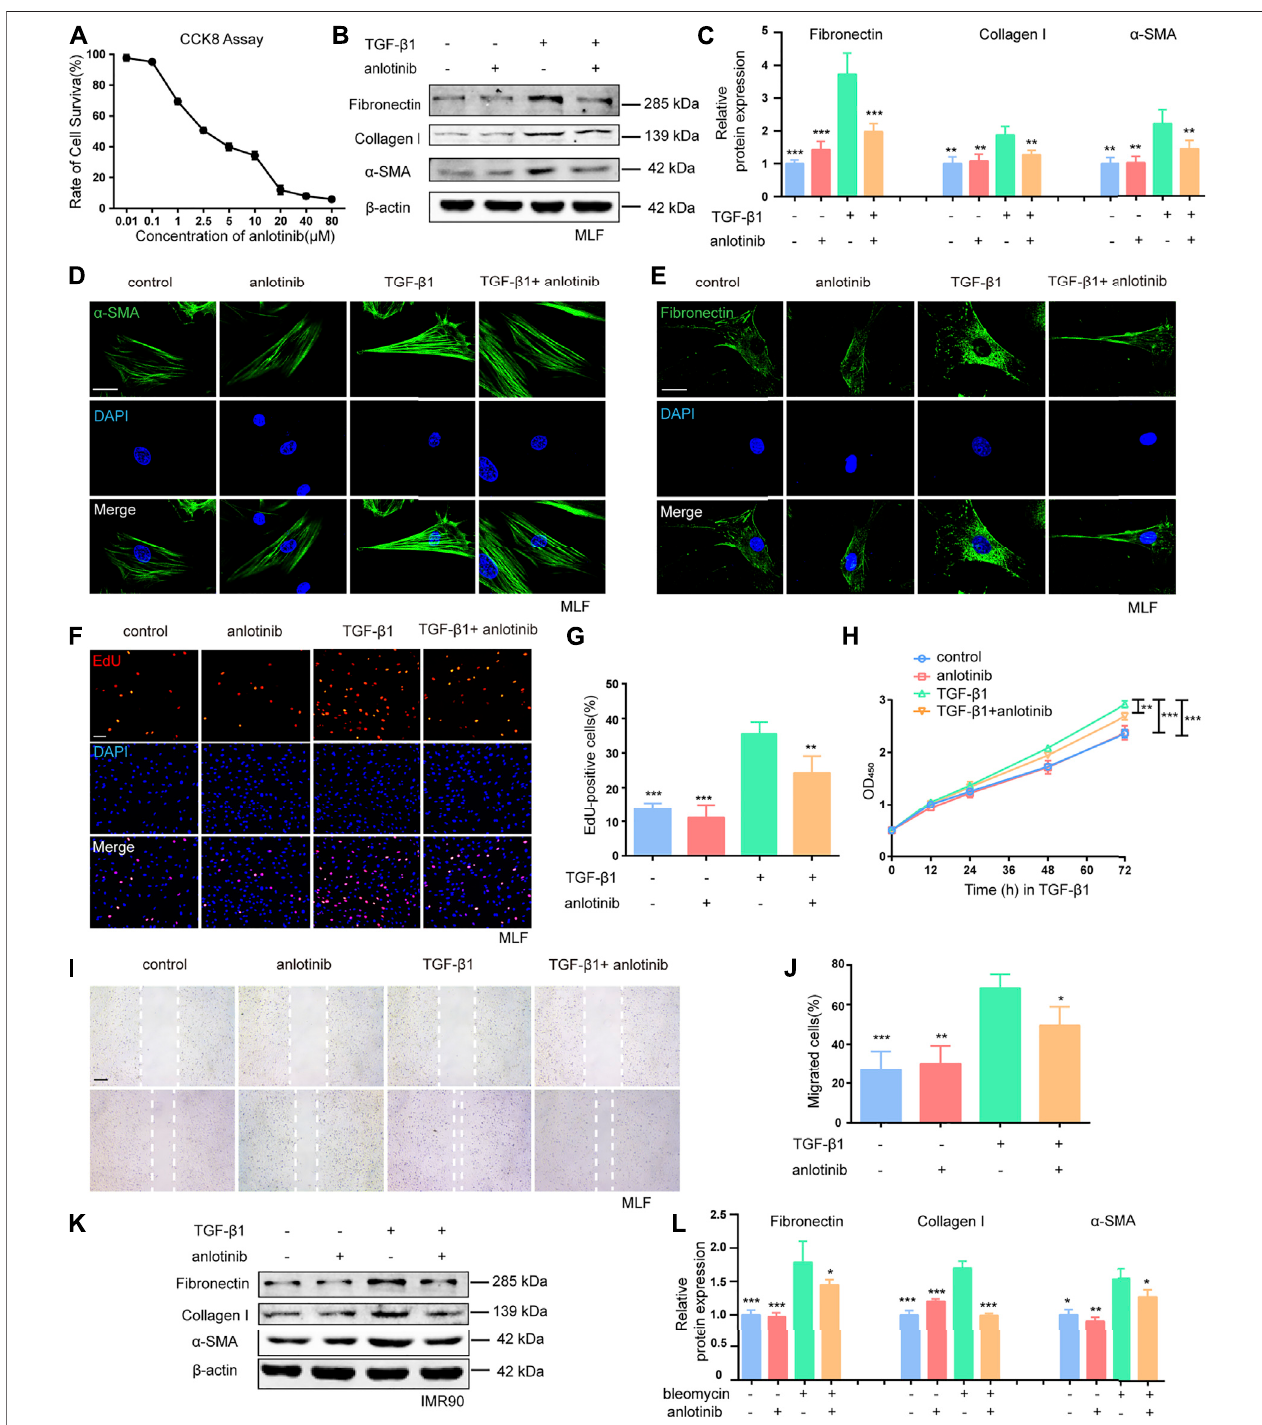
FIGURE 1 | Anlotinib represses myo fi broblast activation and the pro fi brogenic phenotype in vitro . (A) Dose-dependent cytotoxicity of anlotinib in primary mouse lung fi broblast isolated from healthy mice by CCK-8. (B) Western blots analysis of Fibronectin, Collagen I, α -SMA and β -actin in mouse lung fi broblasts treated with anlotinib(1 µM)for3 handthenexposedtoTGF- β 1(10 ng/ml)for3 h,followedbyTGF- β 1foranadditional24 h. (C) Quanti fi cationfortheindicatedprotein(mean ± SD, n (cid:1) 3).Immuno fl uorescencefor α -SMA(green) (D) andFibronectin(green) (E) .DAPI-stained nuclei(blue).Scalebar,25 µm. (F) AnEdUassaywasused toobserve the proliferative cells. Scale bar, 100 µm. (G) The number ofEdU-positive cells was recorded (mean ± SD, n (cid:1) 3). (H) A cck8 assay was used to observe the proliferative cells. (I) Representative images to show scratch-wound assay. Scale bars, 100 µm. Experiments were performed as in B. Images were taken 0, and 24 h after assay (white lines indicate wound edge). (J) Quantitative analysis of migration distance (mean ± SD, n (cid:1) 3). (K) Western blots analysis of Fibronectin, Collagen I, α -SMA and β -actin in IMR90 cells treated with anlotinib (1 µM) for 3 h and then exposed to TGF- β 1 (10 ng/ml) for an additional 24 h. (L) Quanti fi cation for the indicated proteins in IMR90 cells (mean ± SD, n (cid:1) 3). * p < 0.05, ** p < 0.01, *** p < 0.001 VS TGF- β 1-treated group (ANOVA).